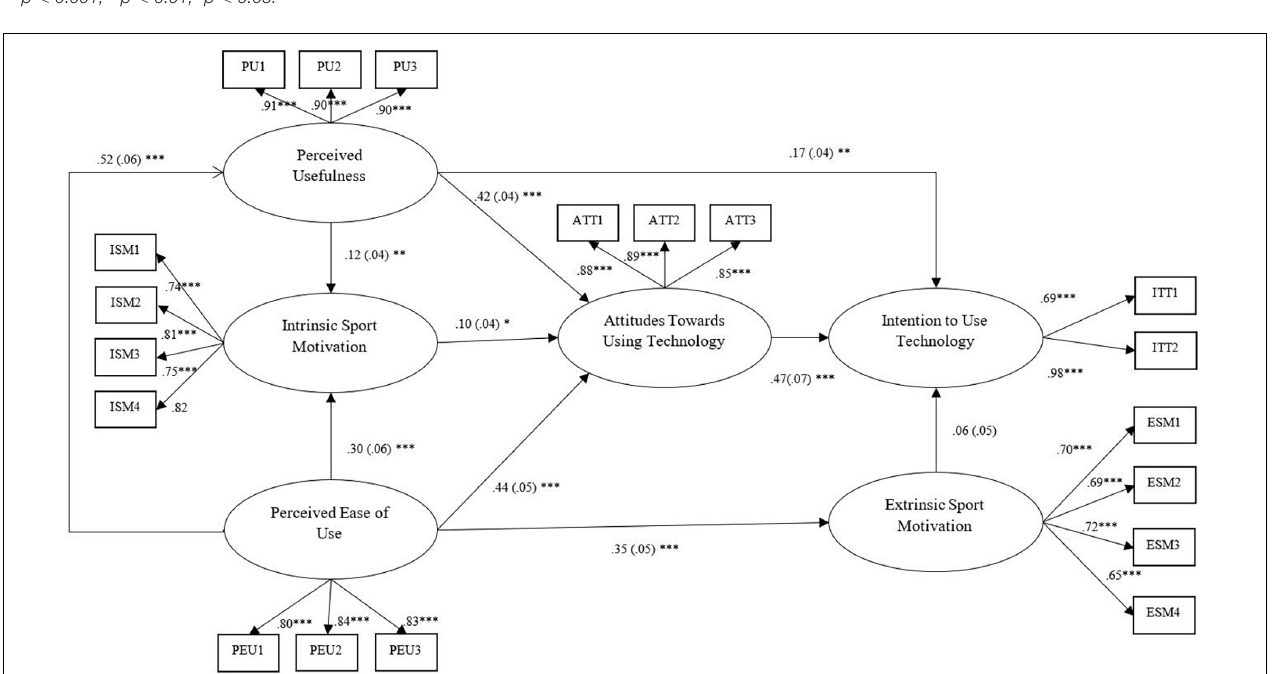
FIGURE 2 | The path coefficients. * p < 0.05; ** p < 0.01; *** p <